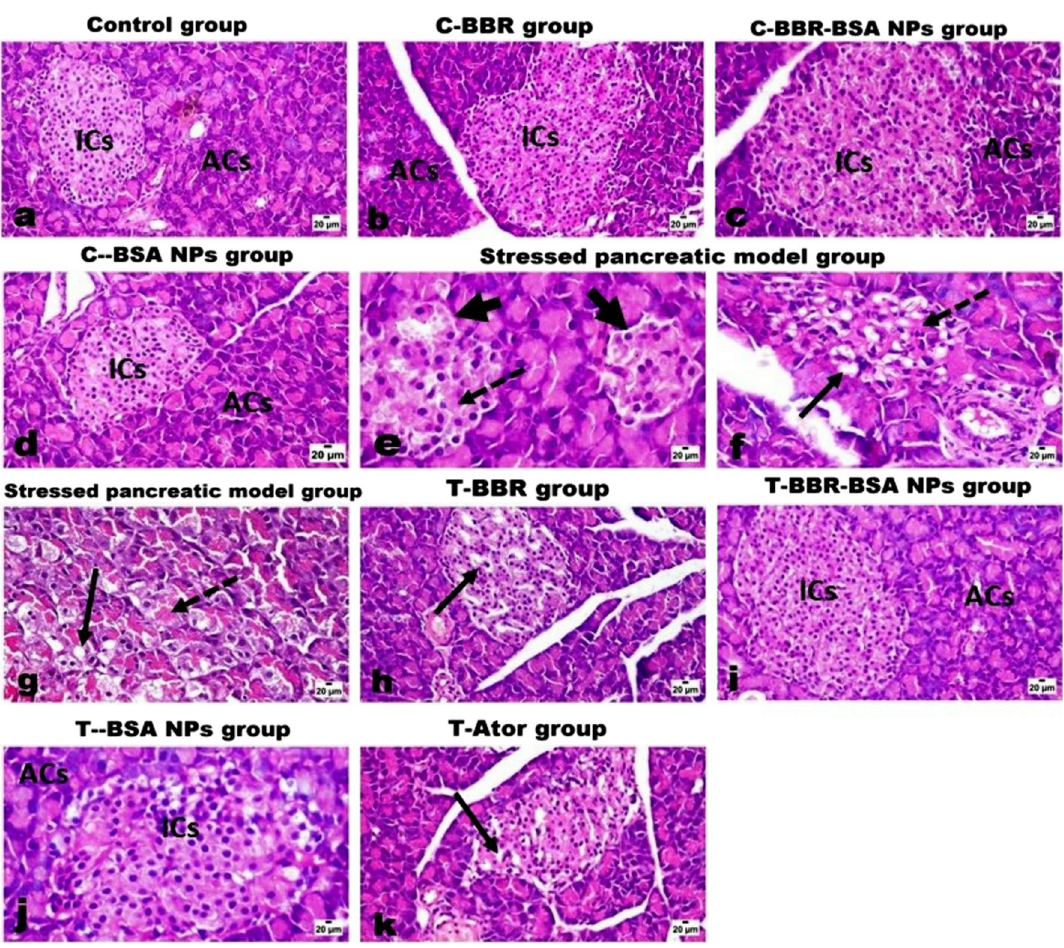
Figure 7. The histopathological investigations of the effect of BBR and BBR-BSA NPs on the stressed pancreatic rat model. Control ( a ), C-BBR ( b ), C-BBR-BSA NPs ( c ), and C-BSA NPs groups ( d ) show normal endocrine islets of Langerhans (ICs) and exocrine acinar cells (ACs). The stressed pancreatic rat model ( e – g ) shows a decrease in size and number of islets cells (thick arrow) with its necrosis (dashed arrow) ( e ), vacuolar degeneration (arrow), and necrosis (dashed arrow) of some islet cells ( f ), and marked swelling, vacuolation (arrow) and necrosis (dashed arrow) of pancreatic acinar cells ( g ). T-BBR group ( h ) shows scattered necrotic islets cells (arrow) and mild pancreatic congested vessels. T-BBR-BSA NPs group ( i ) shows normal islets cells (ICs) as well as the acinar cells (ACs) with only a few islets’ cells with pyknotic nuclei. T-BSA NPs group ( j ) shows normal ACs and mild cytoplasmic vacuolation of a few islets’ cells. T-Ator group ( k ) shows a mild degree of islets cell degeneration (arrow) and scattered necrosis. (H&E, X200, scale bar = 20